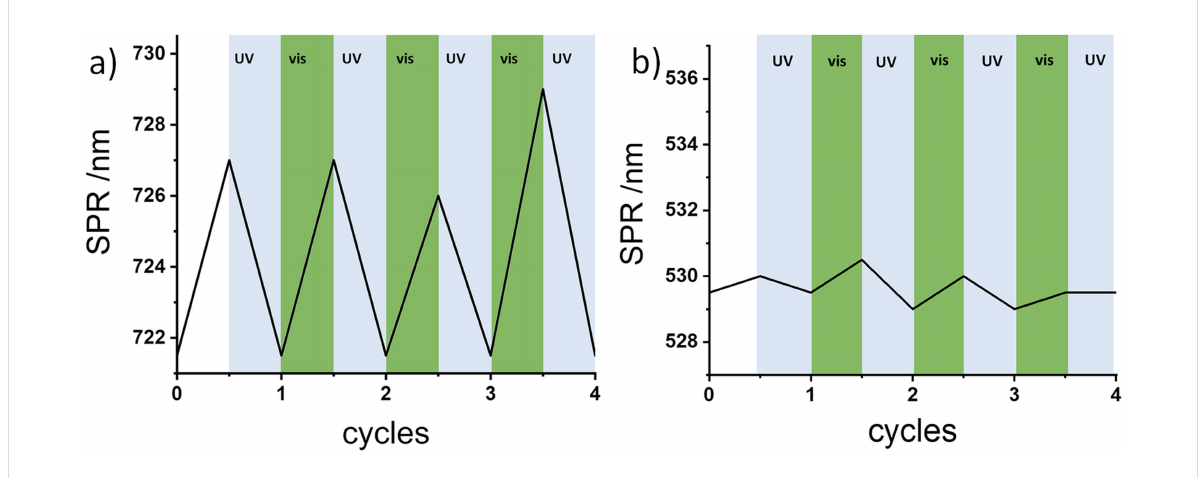
Figure 3: SPR maxima of [tCD+tTEG]AuNR with dAAP during four cycles of irradiation. a) Longitudinal SPR. b) Transversal SPR.